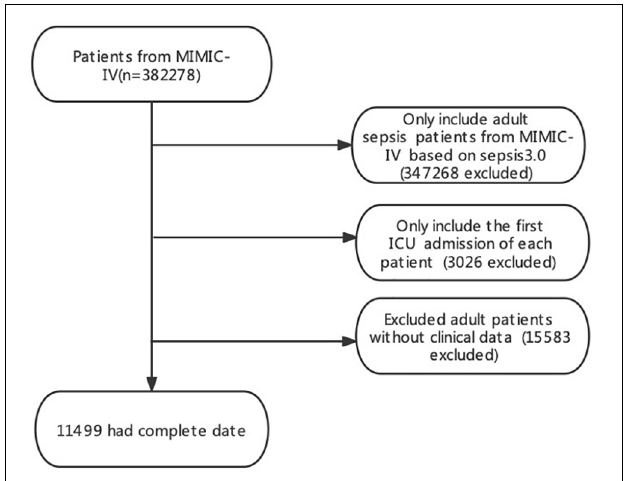
FIGURE 1 | Study flowchart. MIMIC, Medical Information Mart for Intensive Care.